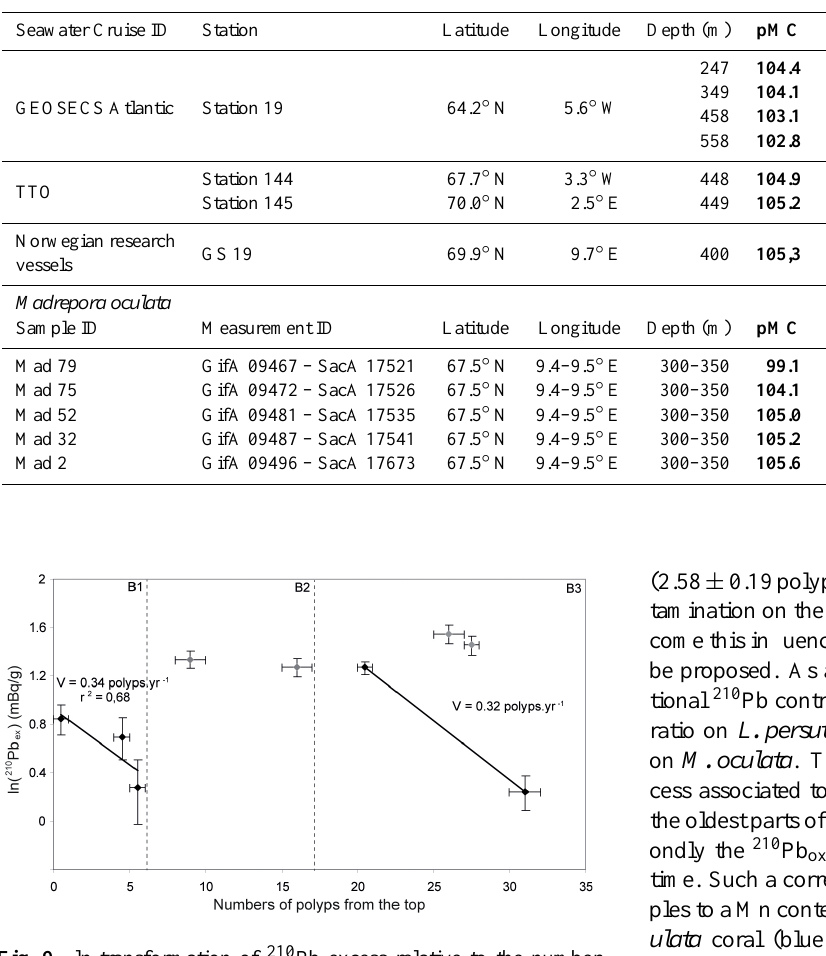
Fig. 9. ln-transformation of 210 Pb excess relative to the number of polyps from the top of the Lophelia pertusa specimen. Grey points presented high 228 Th activities and Mn content that were not included in the linear regression. The slope of these two lin- ear regressions revealed a linear growth rate between 0.34 and 0.32polypyr − 1 with a large uncertainty in relation to few points considered here. Horizontal dotted lines represent the limit of the three sampled branches (B1, B2, and